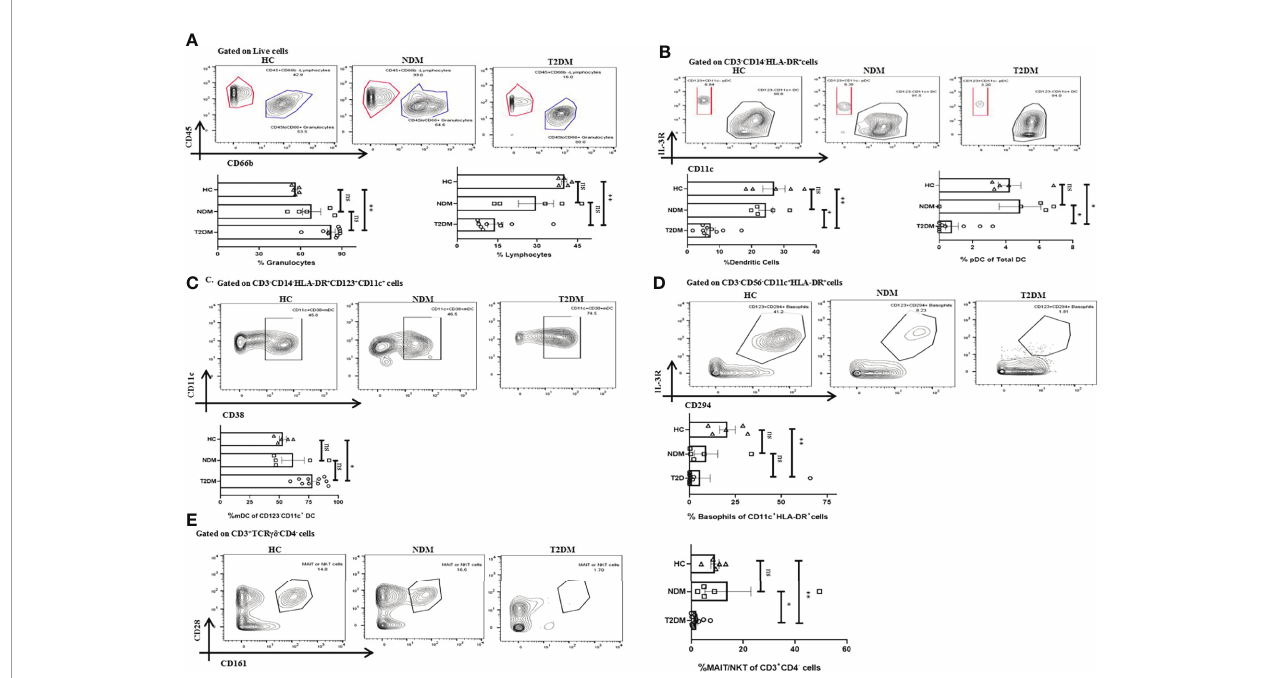
FIGURE 4 | Innate immune cells in T2DM and NDM patients. Whole blood from Covid-19 positive T2DM (n = 10), NDM (n = 5), and Covid-19 negative and non- diabetic healthy controls (n = 5) was stained heavy metal tagged antibody and analyzed in a mass cytometer. (A) Representative gating strategy to identify CD45 + CD66b low lymphocytes and CD45 - CD66b high granulocytes. Statistical analysis of percentage of granulocytes and lymphocytes. (B) Gating strategy for CD123 + CD11c – pDCs. Statistical analysis for the frequency of total DCs and pDCs. (C) Gating strategy for CD11c + CD38 + mDCs. Statistical analysis for the percentage of mDCs. (D) Gating strategy for CD123 + CD294 + basophils. Statistical analysis for the frequency of basophils. (E) Gating strategy for MAIT/NKT cells. Statistical analysis for the frequency of MAIT/NKT cells.The Kruskal Wallis Test (non-parametric) with post-hoc Dunn ’ s multiple comparison test was performed. p < 0.05 was considered statistically signi fi cant (*), p < 0.01 was considered to be very signi fi cant (**), ns, not signi fi cant. All error bars were